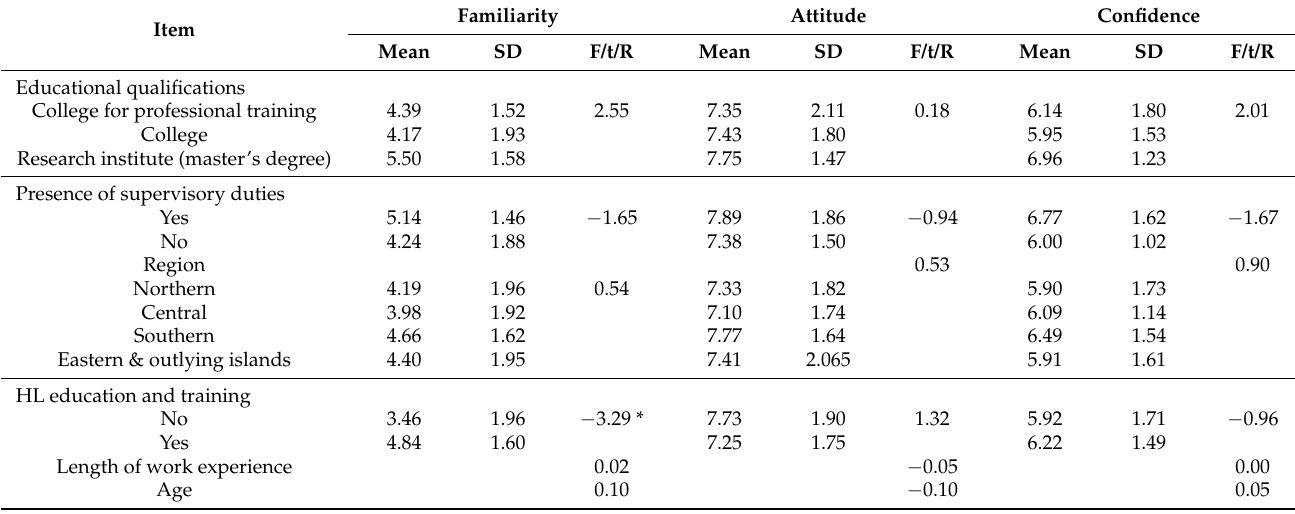
Table 3. Analysis of inter-group differences and correlations regarding familiarity with, attitudes toward, and confidence in implementing HL